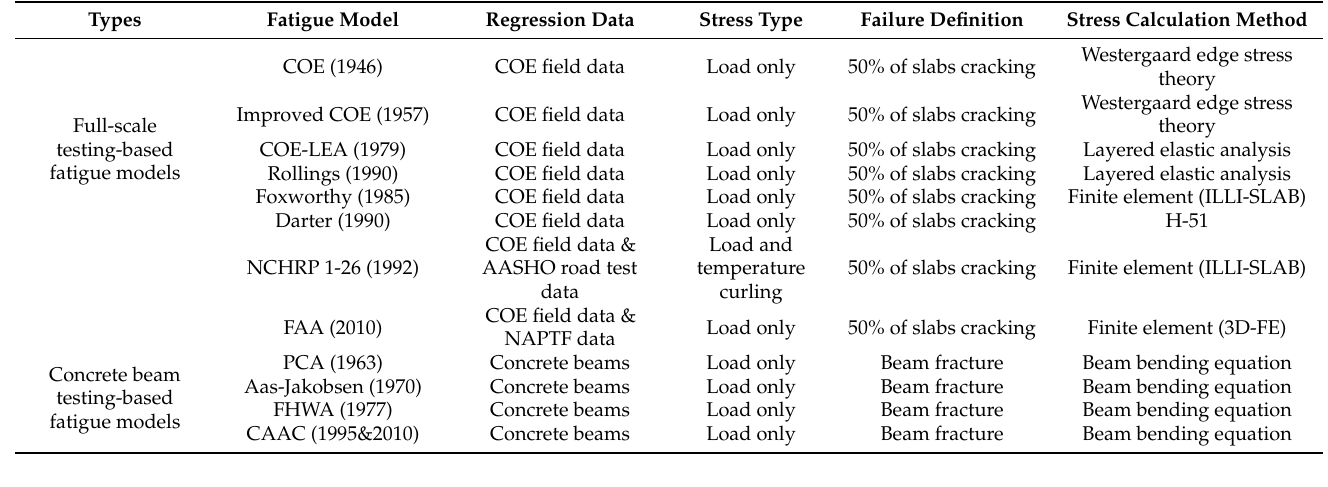
Table 2. Summary of fatigue models for airfield concrete pavements [4].